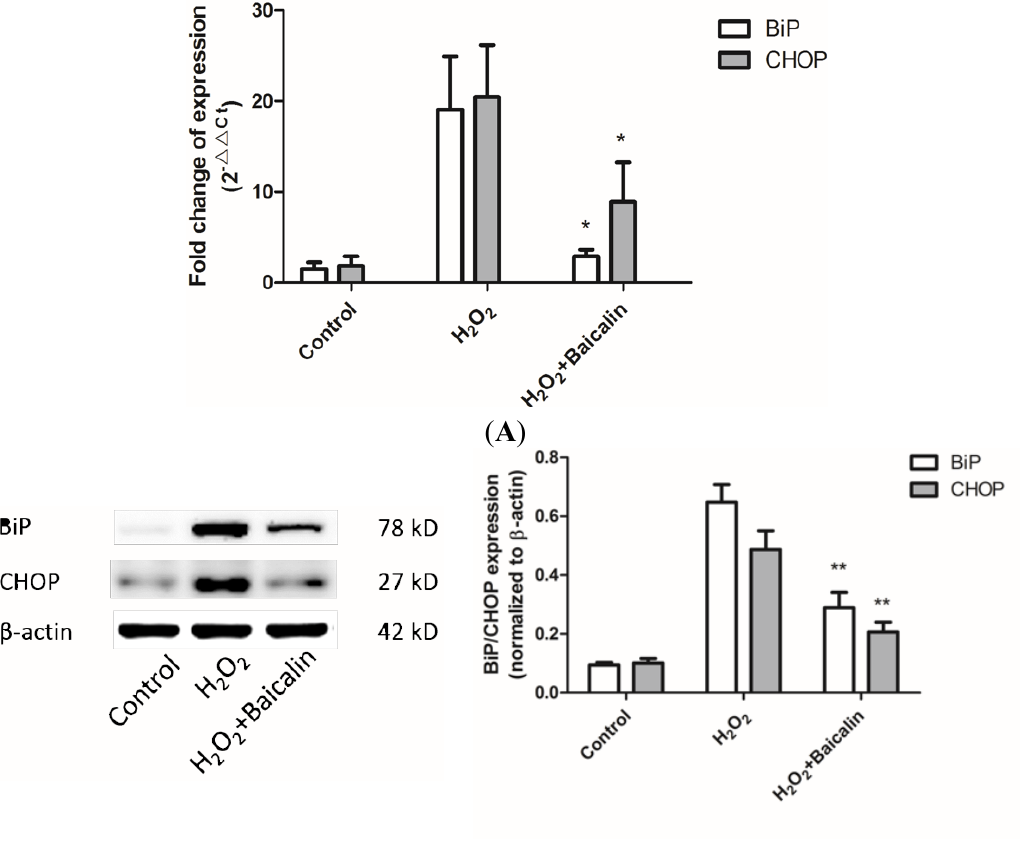
Figure 4. Effects of Baicalin on ER stress hallmarks in cultured HK-2 cells after H O treatment. Real-time PCR ( A ) and Western blot ( B ) analysis showed increased 2 2 expression of ER stress hallmarks, binding immunoglobulin protein (BiP) and C/EBP homologous protein (CHOP), after H O treatment. Baicalin pretreatment inhibited H 2 2 induced upregulation of the expression of ER stress hallmarks. * p < 0.05 and ** p < 0.01, vs. the group with H O treatment, n = 2 2